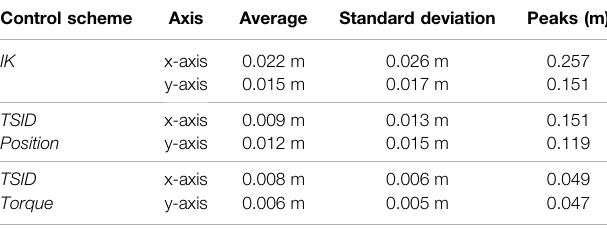
TABLE 7 | Results of the PGM on three gait stages. Simulation Double